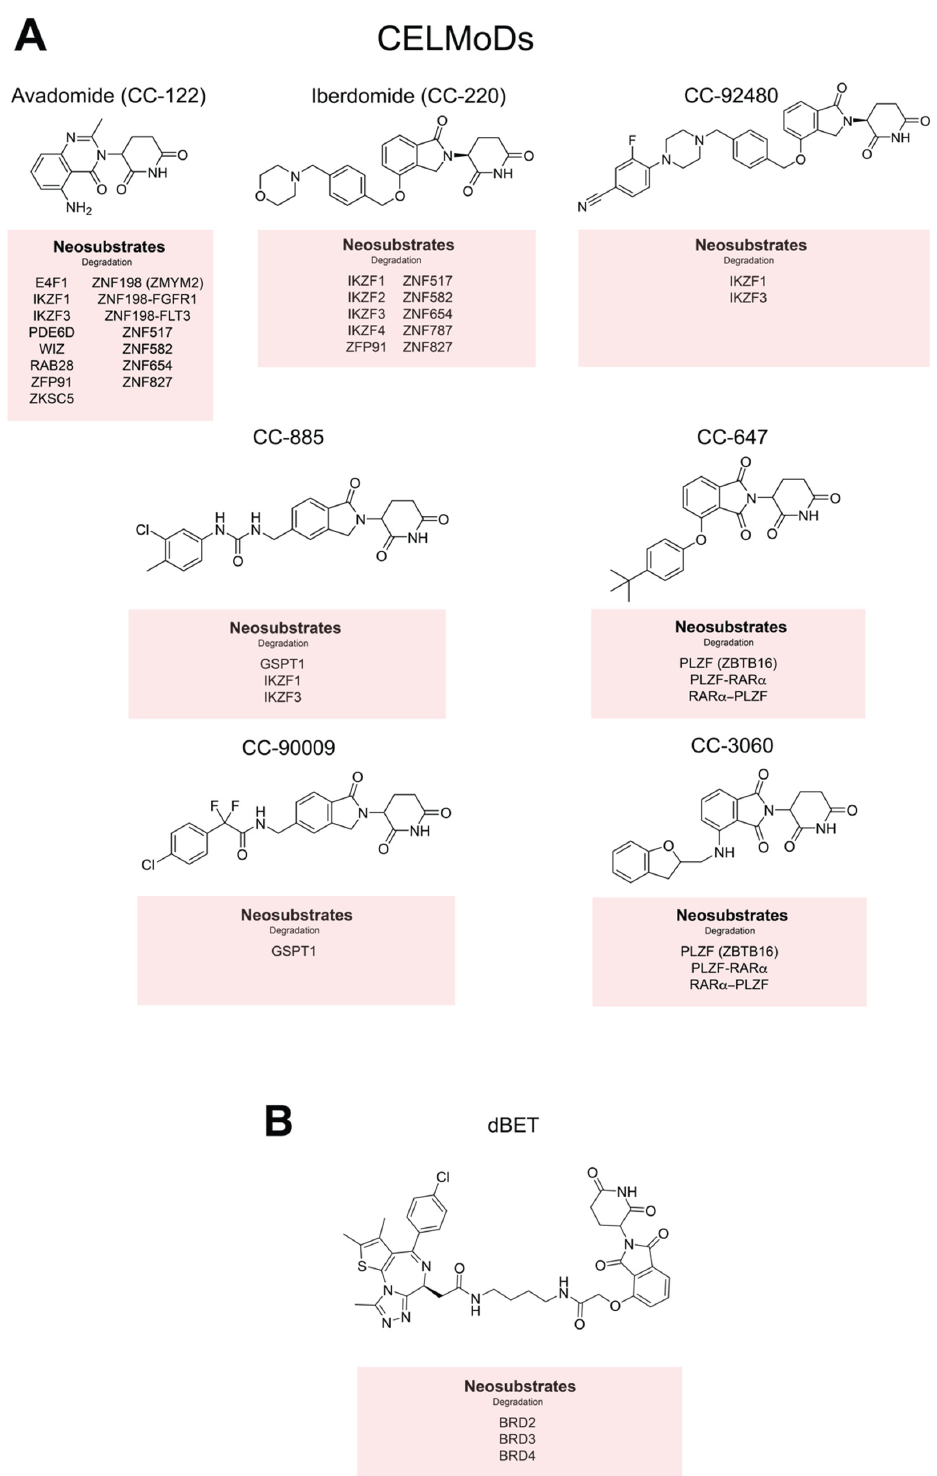
Figure 3. Cereblon E3 ligase modulators (CELMoDs), dBET and their respective protein targets. ( A ) The structure of avadomide, iberdomide, CC-92480, CC-885, CC-90009, CC-647 and CC-3060. Currently disclosed neosubstrates are listed in the red panels beneath. ( B ) The structure of the hetero-bifunctional selective degrader dBET and its targets. Hetero-bifunctional targeted protein degraders hijack the function of E3 ubiquitin ligases to degrade specific vulnerabilities via the ubiquitin–proteasome system.